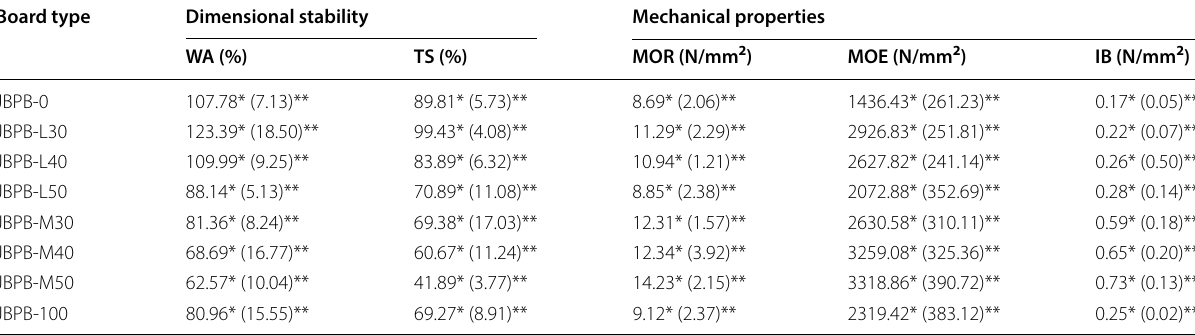
*Values presented are average of 10 samples; **Values presented in parenthesis are standard deviation; L for layered JBPB and M for mixed